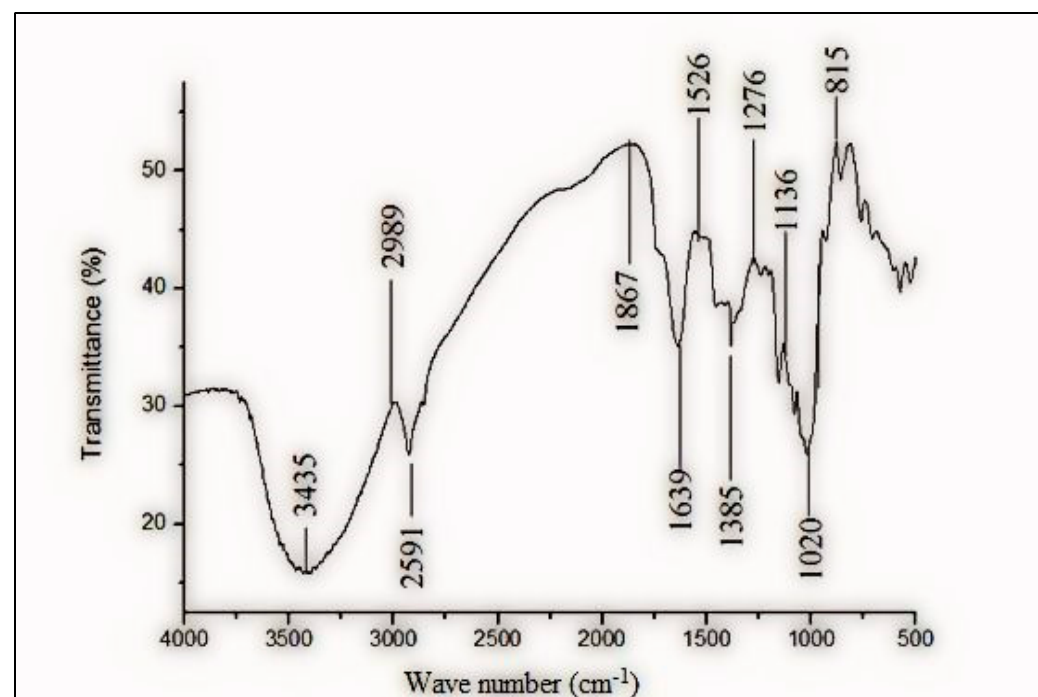
Figure 2. Fourier-transform infrared (FTIR) analysis of LSP.